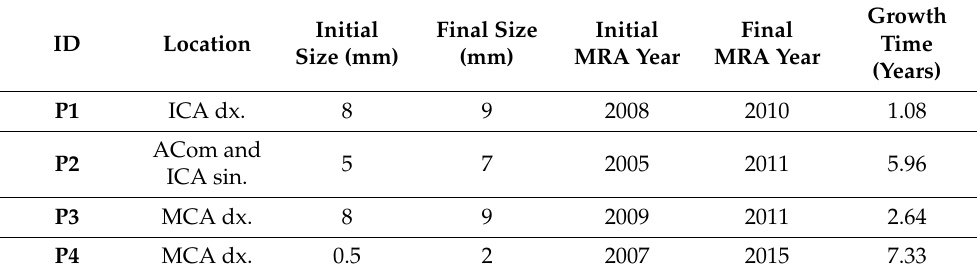
Table 1. Aneurysm geometry